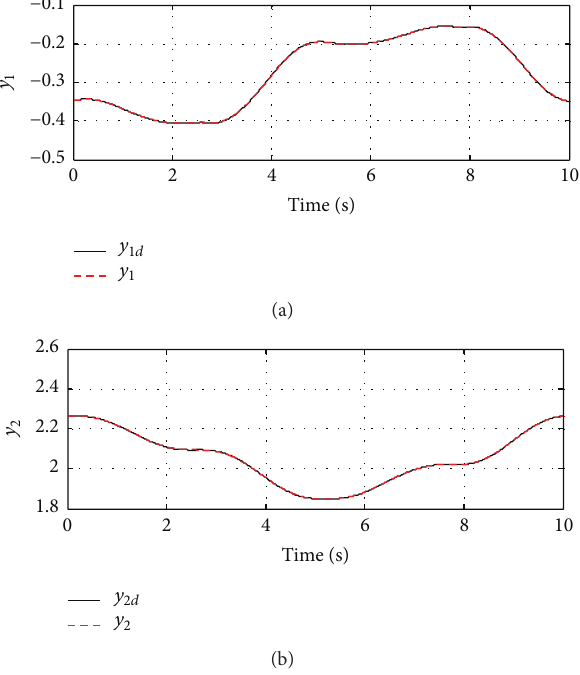
Figure 10: Tracking trajectories of noncollocated